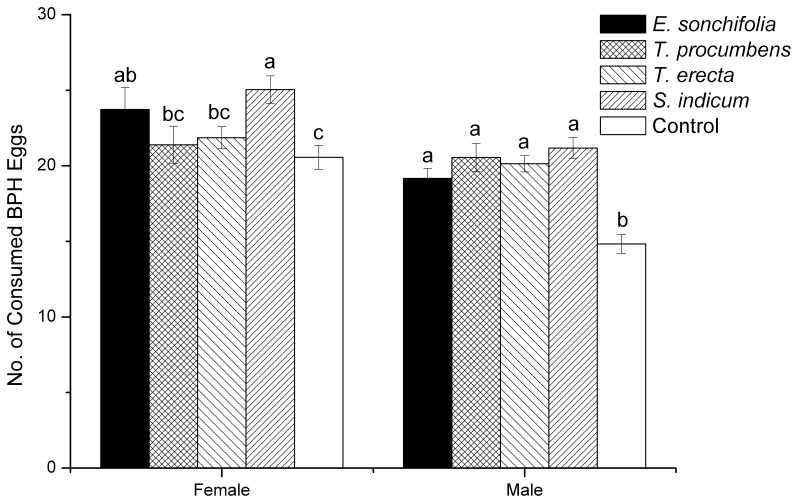
Effect of access to flowering plants of varying plant species on predation by C. lividipennis.Adult predators were confined with ad libitum brown planthopper eggs plus a flowering shoot or water (control). Numbers of consumed eggs are back transformed.